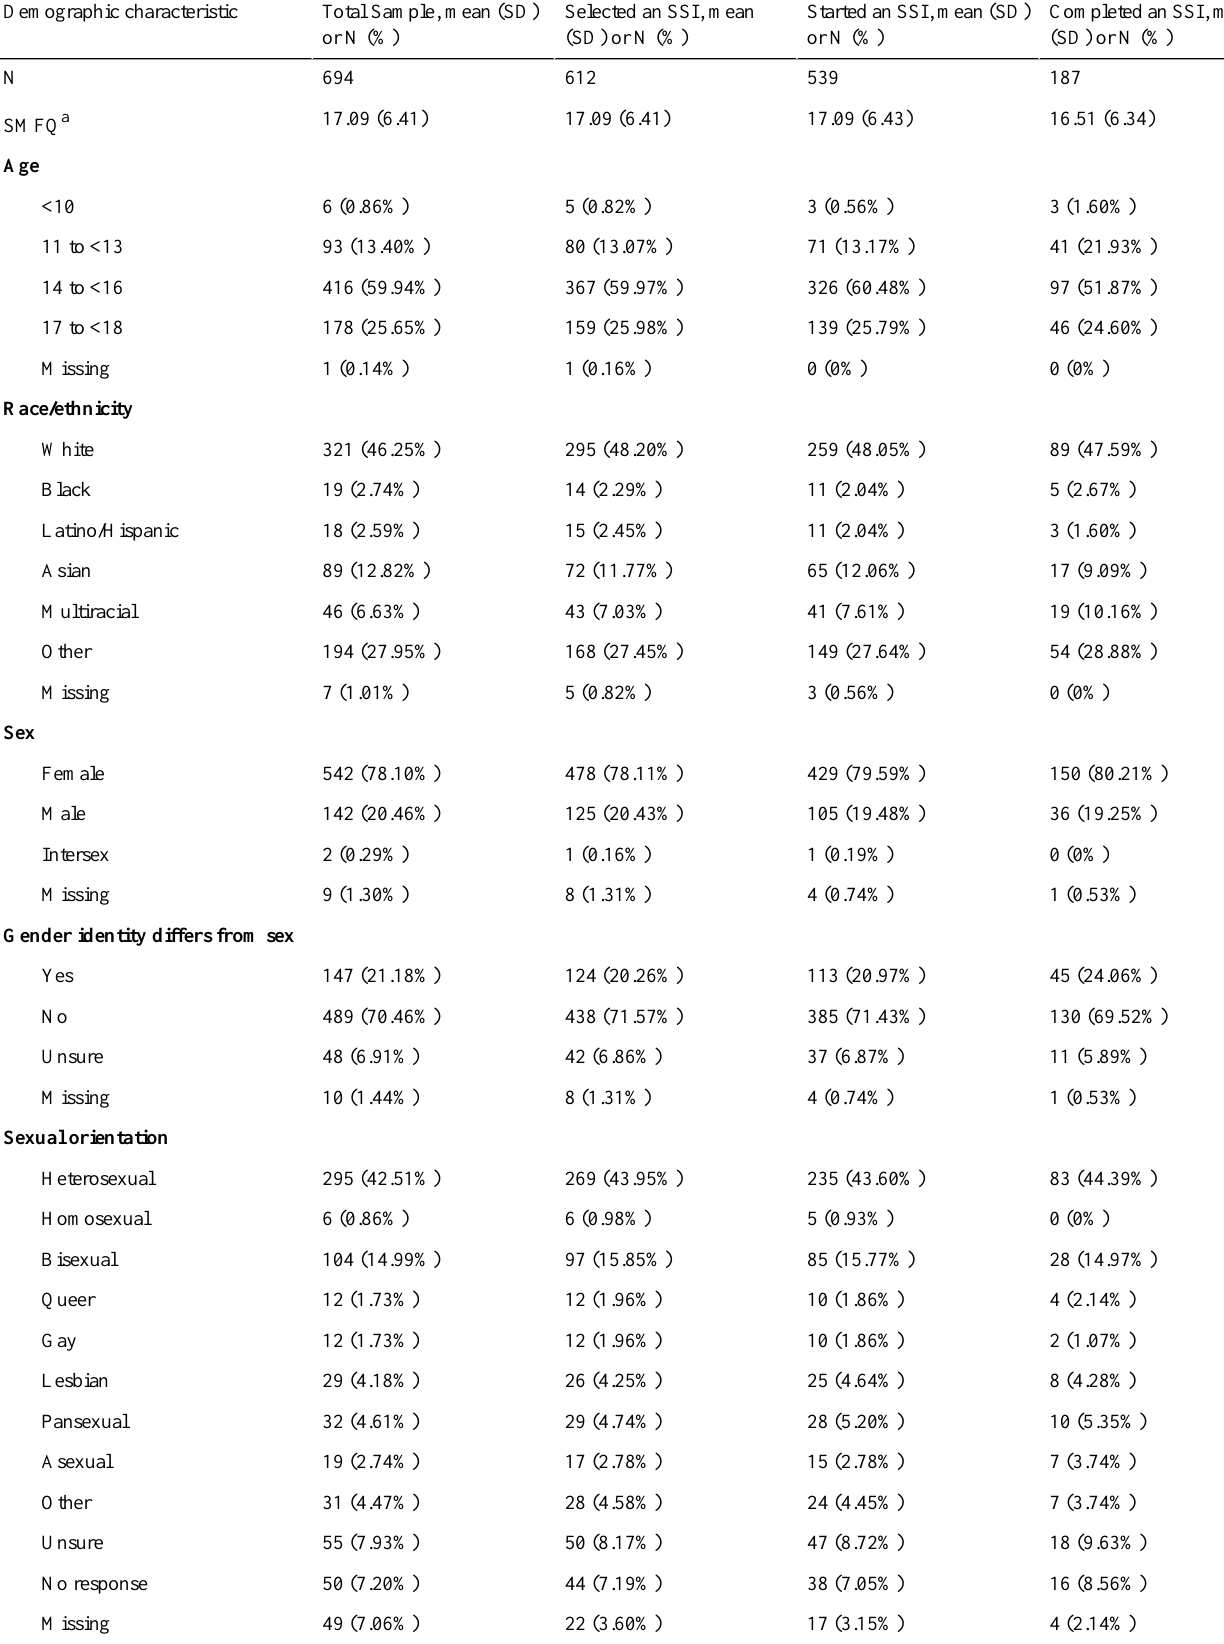
Table 1. Full sample demographics by SSI completion